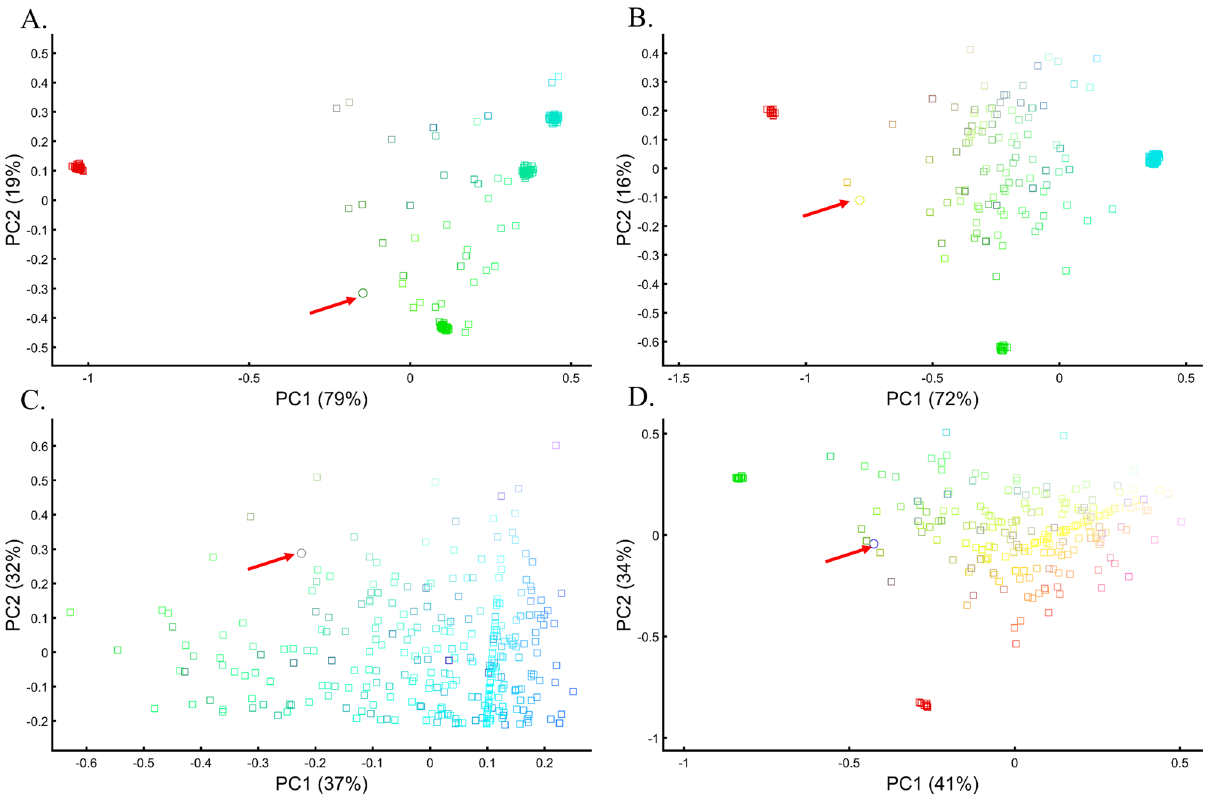
Figure 23. Inferring single individual ancestries using reference individuals. In ( A ) Using even-sized samples from reference populations ( n = 37): Red [1,0,0], Green [0,1,0], bright Cyan [0, 0.9, 0.8], dark Cyan [0, 0.9, 0.6], heterogeneous darker Cyan [0, 0.9, 0.4] with high standard deviation (0.25) with a light Green test individual [0, 0.5, 0]. In ( B ) Using the same reference populations as in ( A ) with uneven-sizes: Red ( n = 15), Green ( n = 15), bright Cyan ( n = 100), dark Cyan ( n = 15), heterogeneous darker Cyan ( n = 100), with a Yellow test indiviaul (1,1,0). In ( C ) A heterogeneous Cyan population [0, 1, 1] ( n = 300) with high standard deviation (0.25) and a Grey test individual (0.5, 0.5, 0.5). In ( D ) Red [1,0,0] ( n = 10), Green [0,1,0] ( n = 10), a heterogeneous population [1, 1, 0.5] ( n = 200) and a Blue test individual